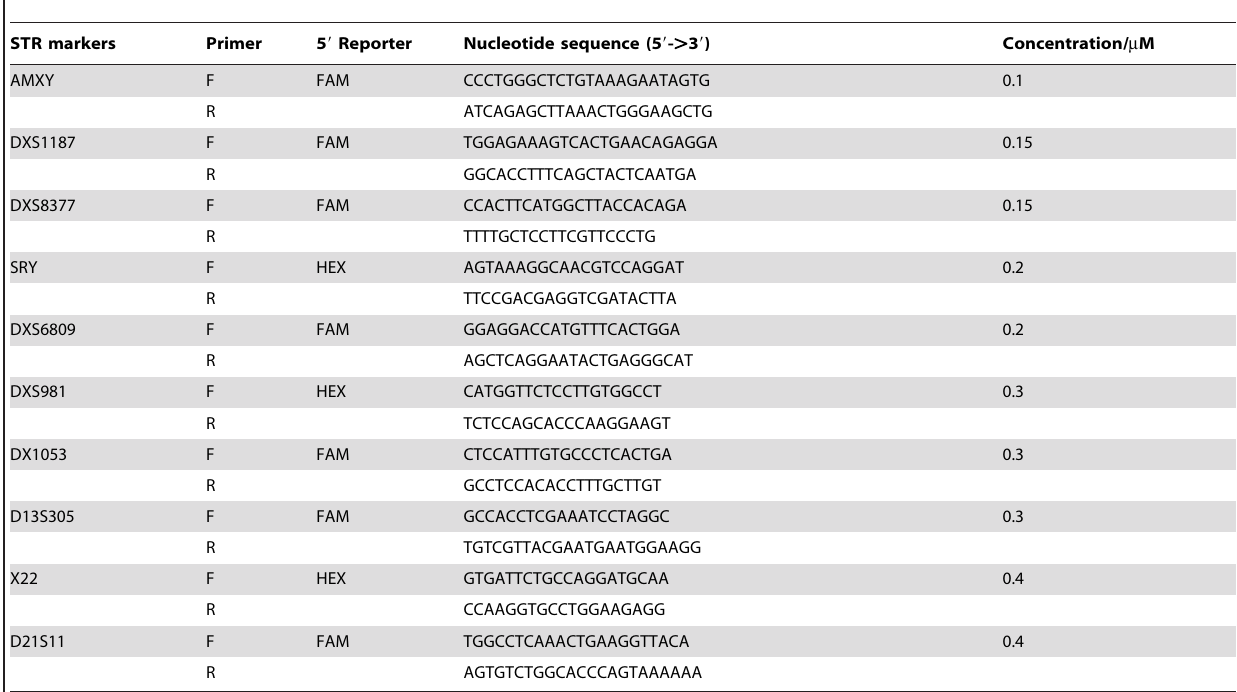
Table 1. Marker and primer composition of the new 10-plex assay for the detection of sex chromosome aneuploidies.